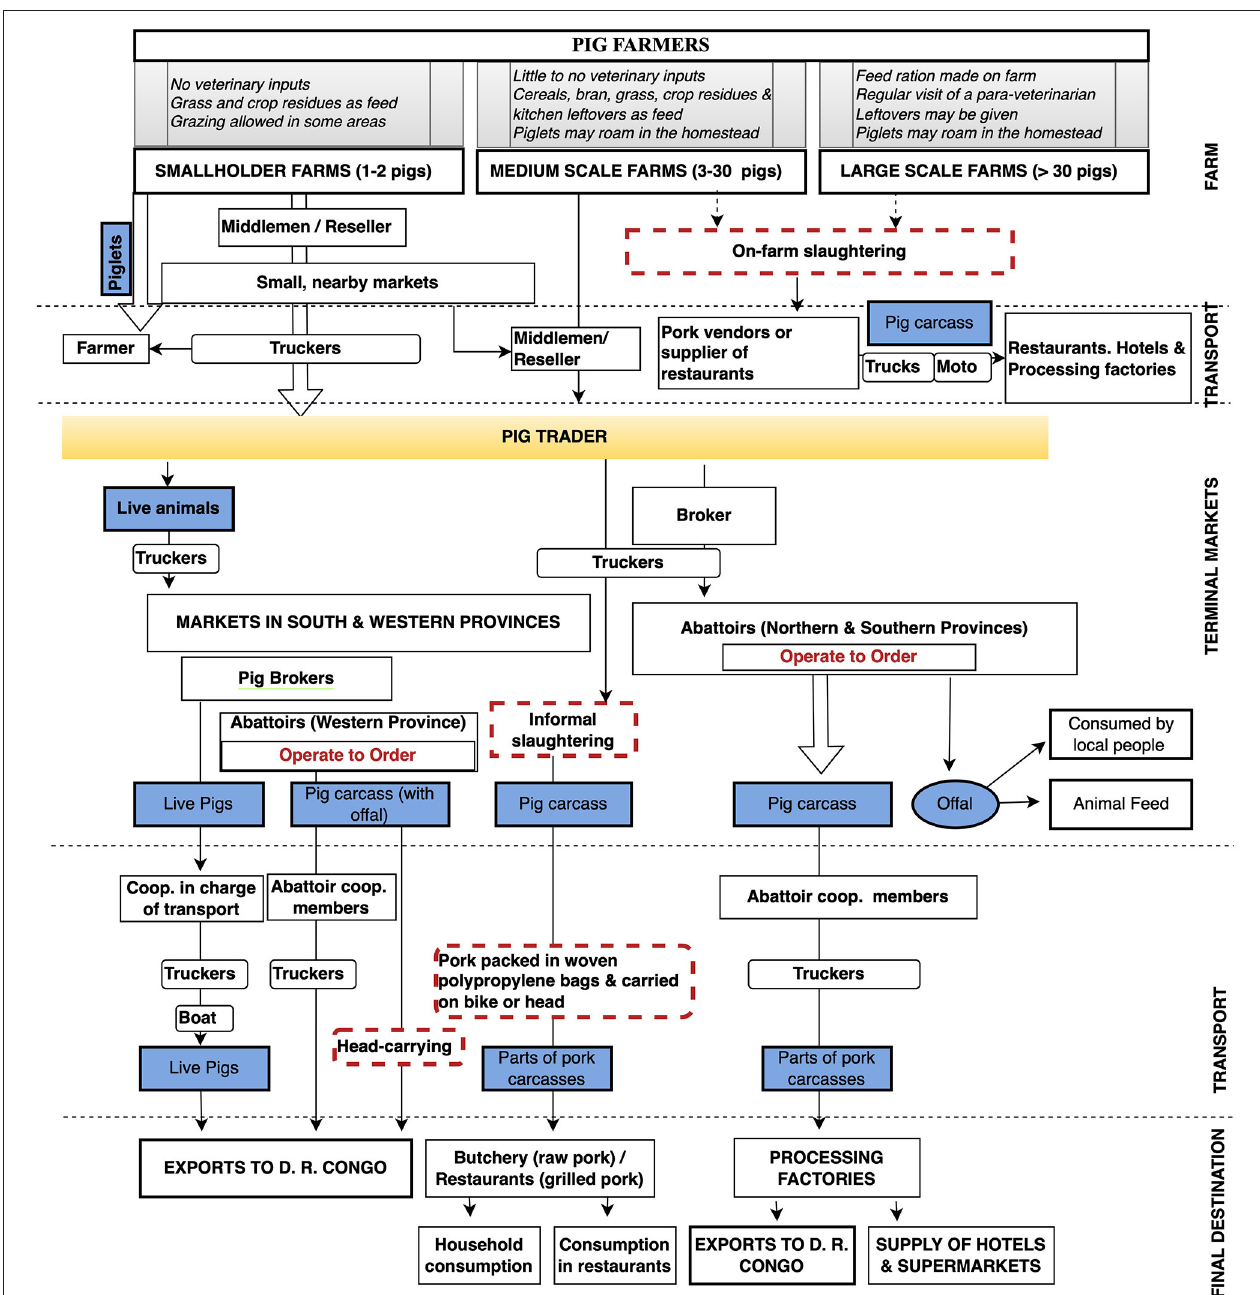
FIGURE 2 | The overall structure of the Rwanda pig value chain. The flow of live pigs and pork in Rwanda. Large arrows indicate more important pathways while dotted red boxes highlight some sanitary risks in the value chain.